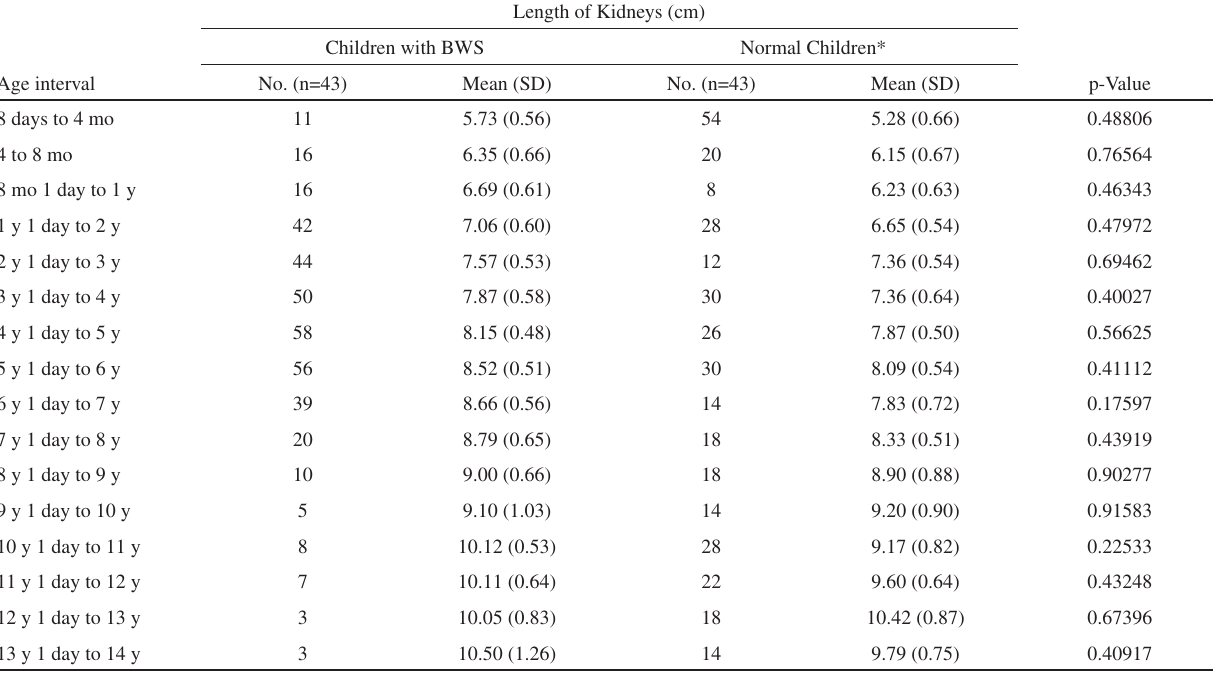
Length of Kidneys